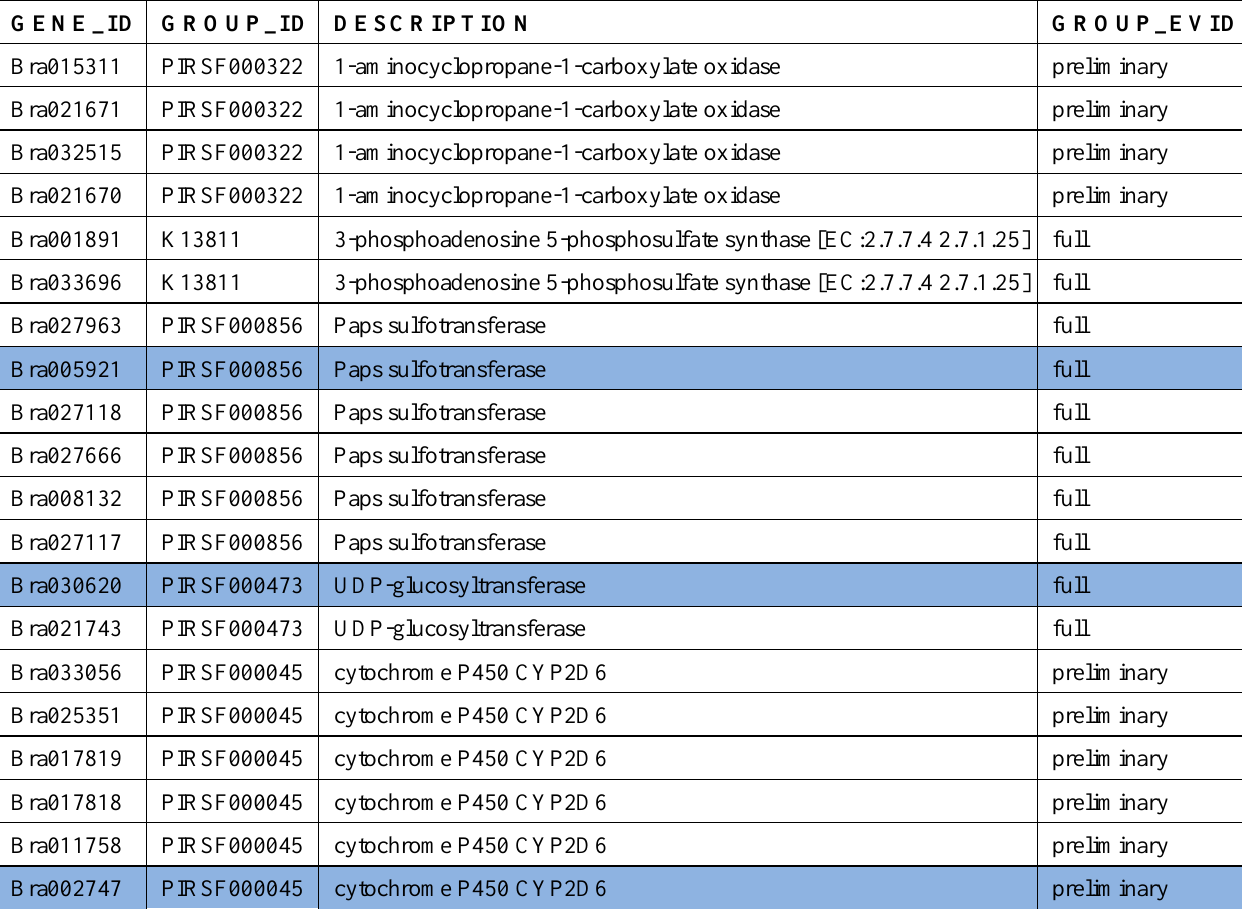
Table S4: 20 candidate genes which are supposed to be responsible for the different glucosinolate levels between two DH lines. Highlighted genes are located in the same scaffold with four hypothetical myb genes which are differentially expressed in our time course